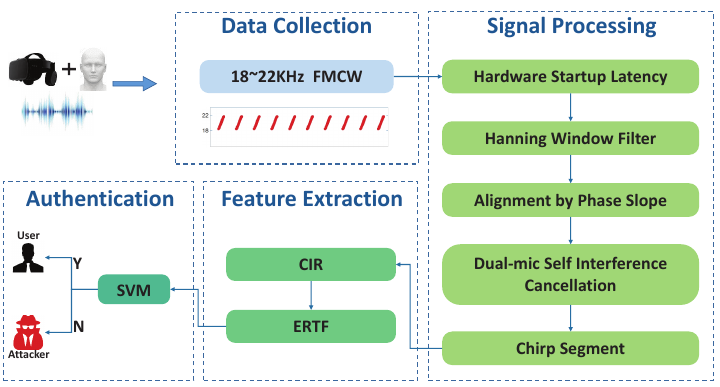
Figure 4. The authentication framework of MetaEar consists of four components: data collection, signal processing, feature extraction, and